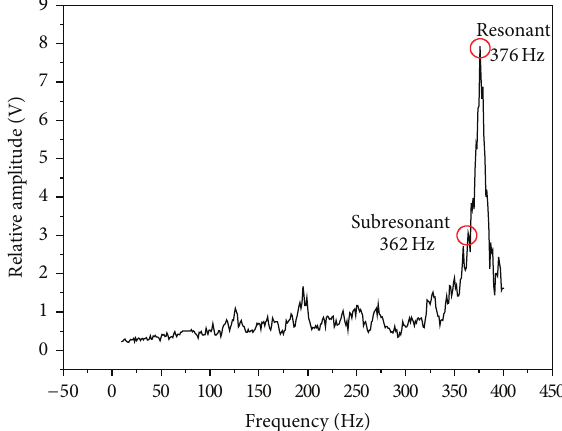
Figure 5: The spectrum map of the